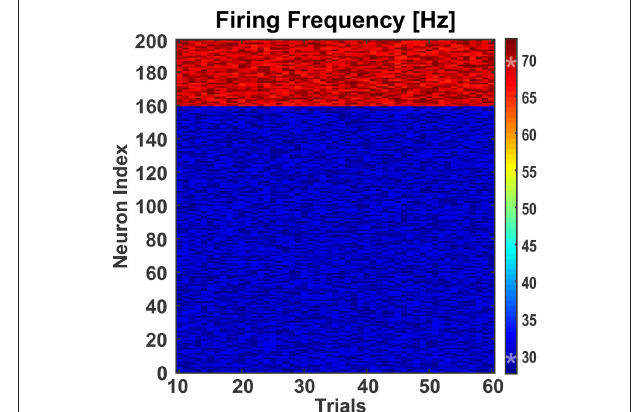
FIGURE 5 | Effect of background activity on network. To test the effect of differential modulation of excitatory and inhibitory neurons, the small-world network was fed with excitatory synaptic inputs from a background population consisting of 30 Izhikevich neurons. These neurons were stimulated with a randomly generated zero-mean Gaussian noise of variance 4.6 . This generated enough excitatory synaptic conductance to activate the target population of excitatory and inhibitory neurons. Over 60 trials, the mean firing frequencies of the excitatory and inhibitory neurons were 30.00 Hz ( ± 0.11 Hz) and 68.98 Hz ( ± 0.27 Hz), respectively. The two asterisks (‘ * ’) on the colorbar represent the mean firing